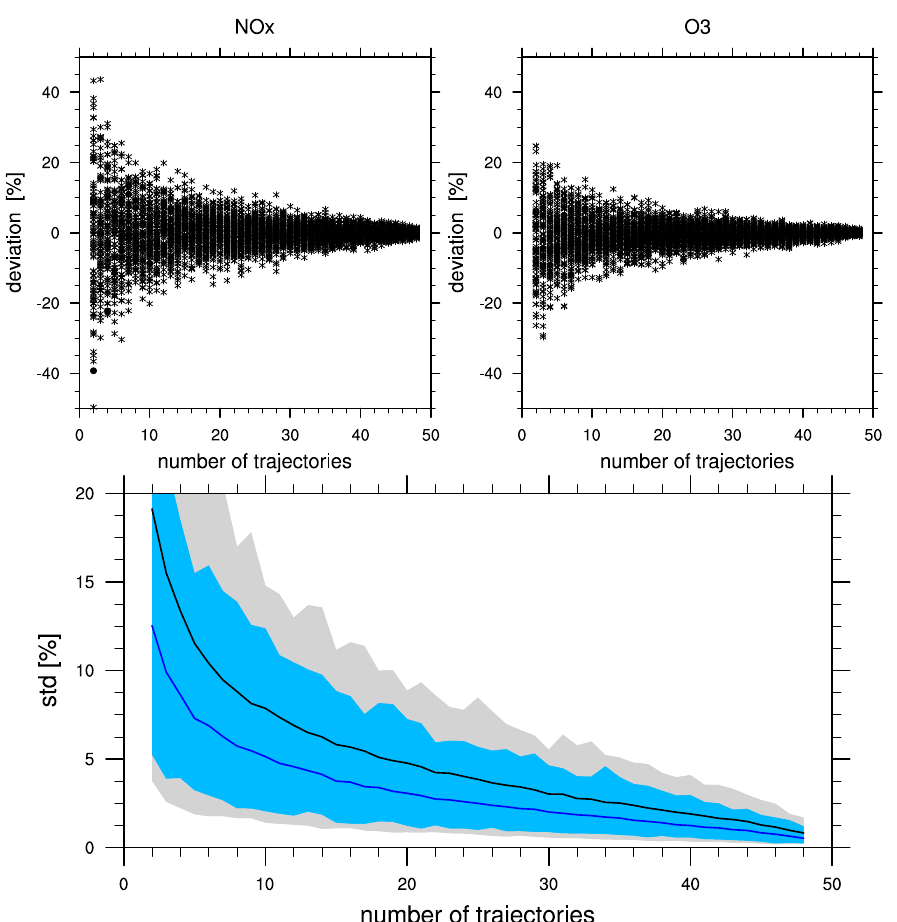
Fig. 6. Top: deviations [%] of possible results of the monthly mean January NO x mixing ratio (left) and ozone mixing ratio (right) for emissions at 200hPa and 50 ◦ N, 45 ◦ W as a function of the number of air parcel trajectories simulated. The deviation is relative to the result using 50 air parcel trajectories. Bottom: standard deviations [%] of the results for NO x and ozone shown as a function of the number of air parcel trajectories used for 24 different time-region grid points (shading: grey for NO x and blue for ozone) and the mean of the standard deviation over the 24 points (upper black line for NO x , lower dark-blue line for ozone).